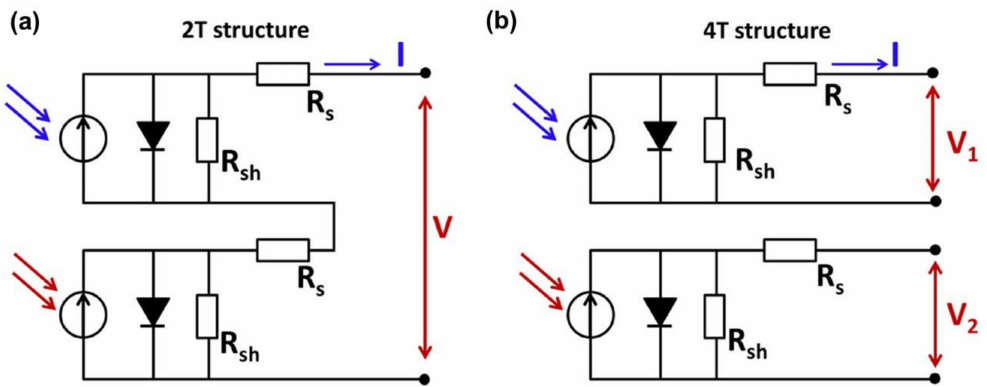
Figure 2. Equivalent circuit models of 2T ( a ) and 4T ( b ) tandem cells. In these schemes, I, R sh , and R s indicate the generated photocurrent, the shunt, and the series resistances, respectively. Finally, V is the output voltage. Blu and red arrows indicate the spectral response of the top and bottom cells, that work in the visible (400–800 nm) and IR (800–1100 nm) ranges, respectively. (Figure reprinted from Cheng et al. [17], Copyright (2023) with permission of SusMat).